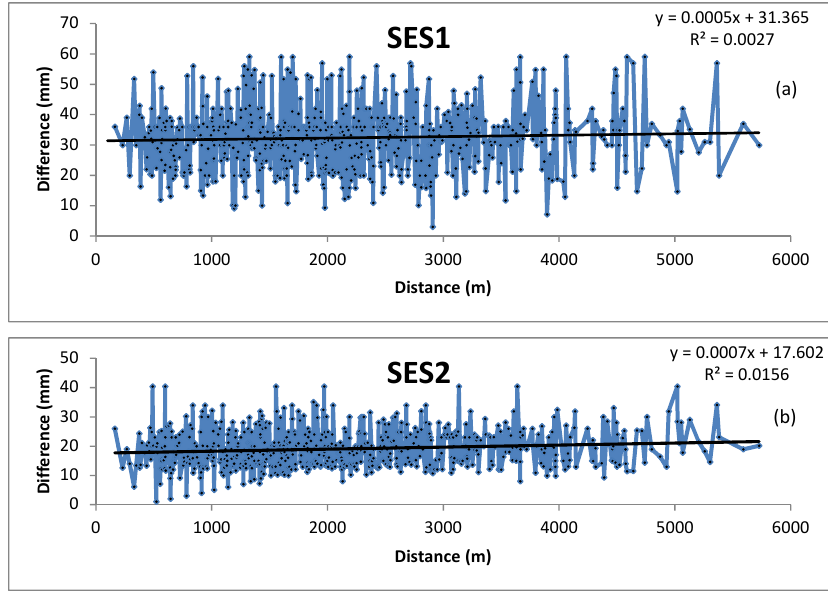
Figure A1. Rainfall variation in space with distance for ( a ) SES1 and ( b ) SES2.